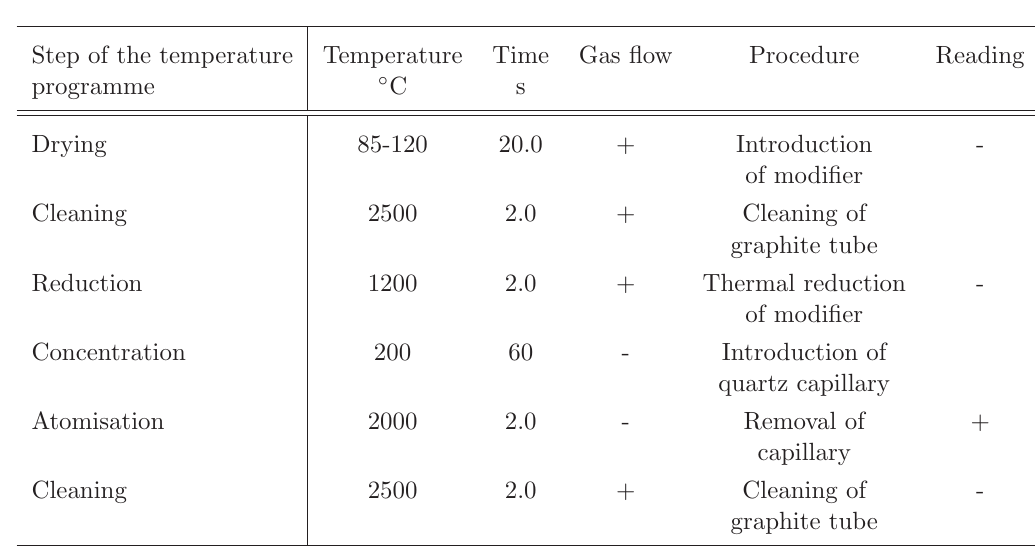
Table 2 The temperature programme followed for determination of arsenic by the method of atomic absorption spectrometry with generation of hydrides and in-situ pre-concentration in a graphite tube.